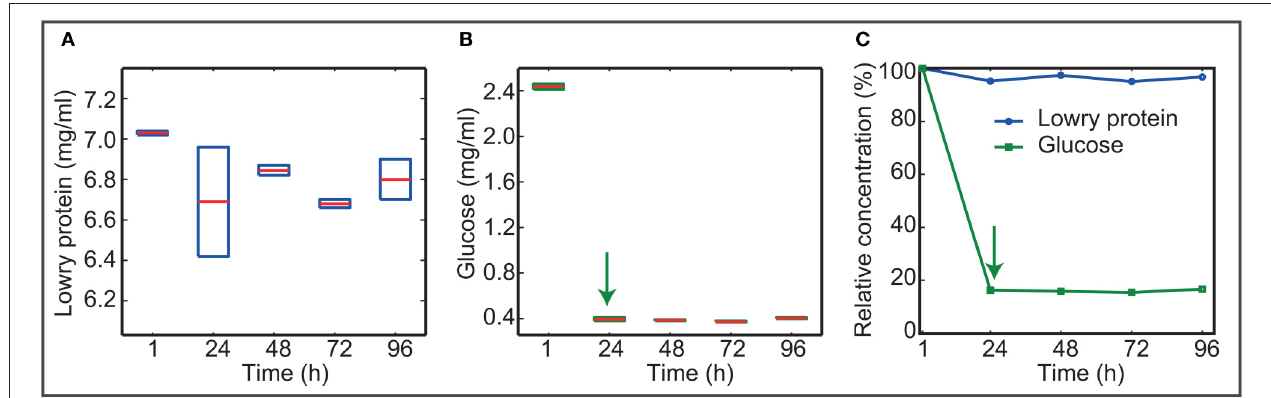
FIGURE 4 | Nutrients in the bulk throughout time. (A,B) Present the absolute concentration of nutrients as measured in the bulk liquid. Boxplots reflect the variability among experimental replicates. (C) Shows the mean relative values using the concentrations at 1 h as the reference. Data show that L1A1 prefers glucose to protein as a source of nutrients. After 24 h cells stop consuming